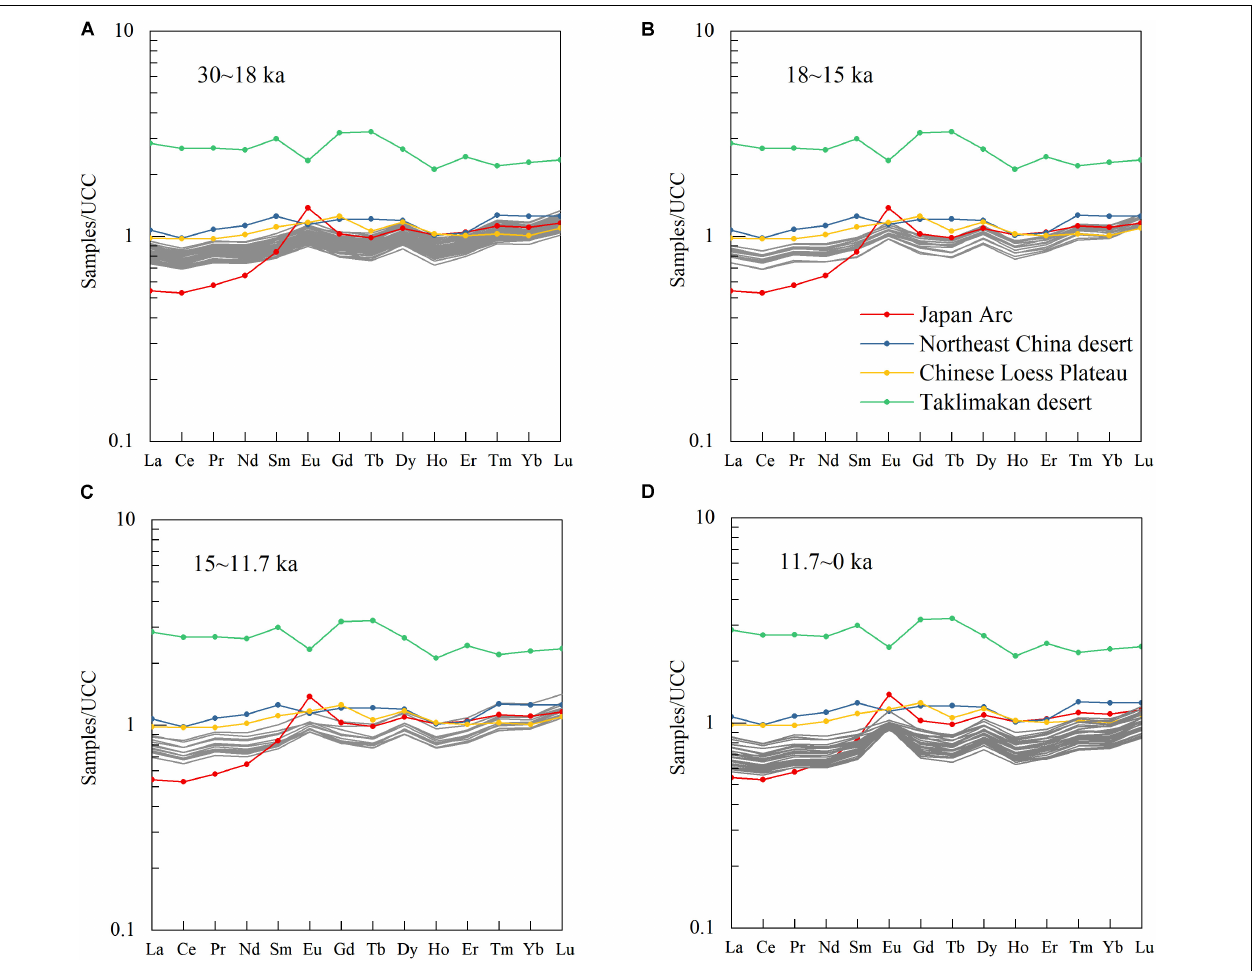
FIGURE 5 | Comparisons of UCC-normalized REE patterns among sediments of core LV53-18-2, Japan Arc (Togashi et al., 2000), Northeast China desert (Xie et al., 2019), Chinese Loess Plateau (Jahn et al., 2001), and Taklimakan desert (Yang X. et al., 2007). The REE patterns are shown with different periods: the late last glaciation (30 ∼ 18 ka, A ), early last deglacial period (18 ∼ 15, B ), late last deglacial period (15 ∼ 11.7 ka, C ), and the Holocene (11.7 ∼ 0 ka, D